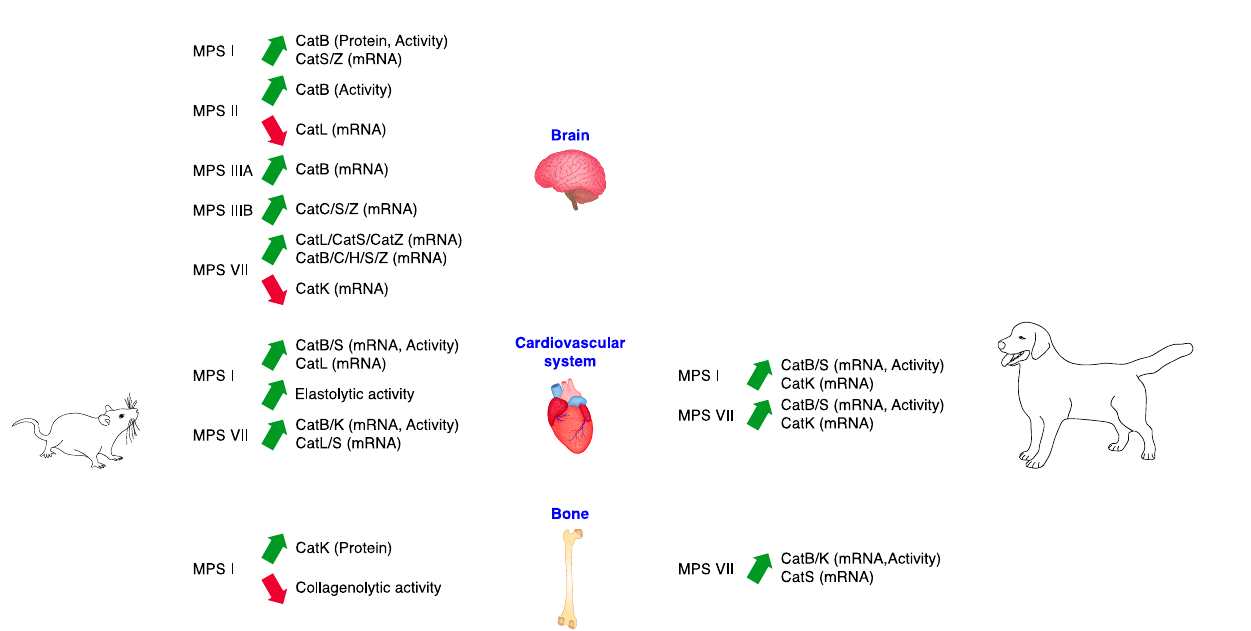
Figure 2. Cathepsins (Cat) expression (mRNA, protein) and activity in MPS animal models. Green and red arrows imply an increase or a decrease of the mRNA, protein and/or activity level, respec- tively.